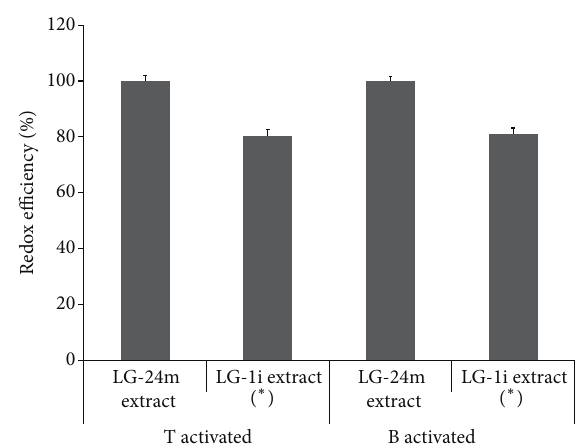
Figure 3: Redox efficiency (cell free radical level/extract phenolic content) of 100 𝜇 g/mL aqueous L. grisebachii extracts (LG-24m: cold 24 h maceration versus LG-1i: hot 1h infusion) in T- and B-activated cultures treated for 72 h. Results were averaged from three separate experiments ( ∗ 𝑃 < 0.01